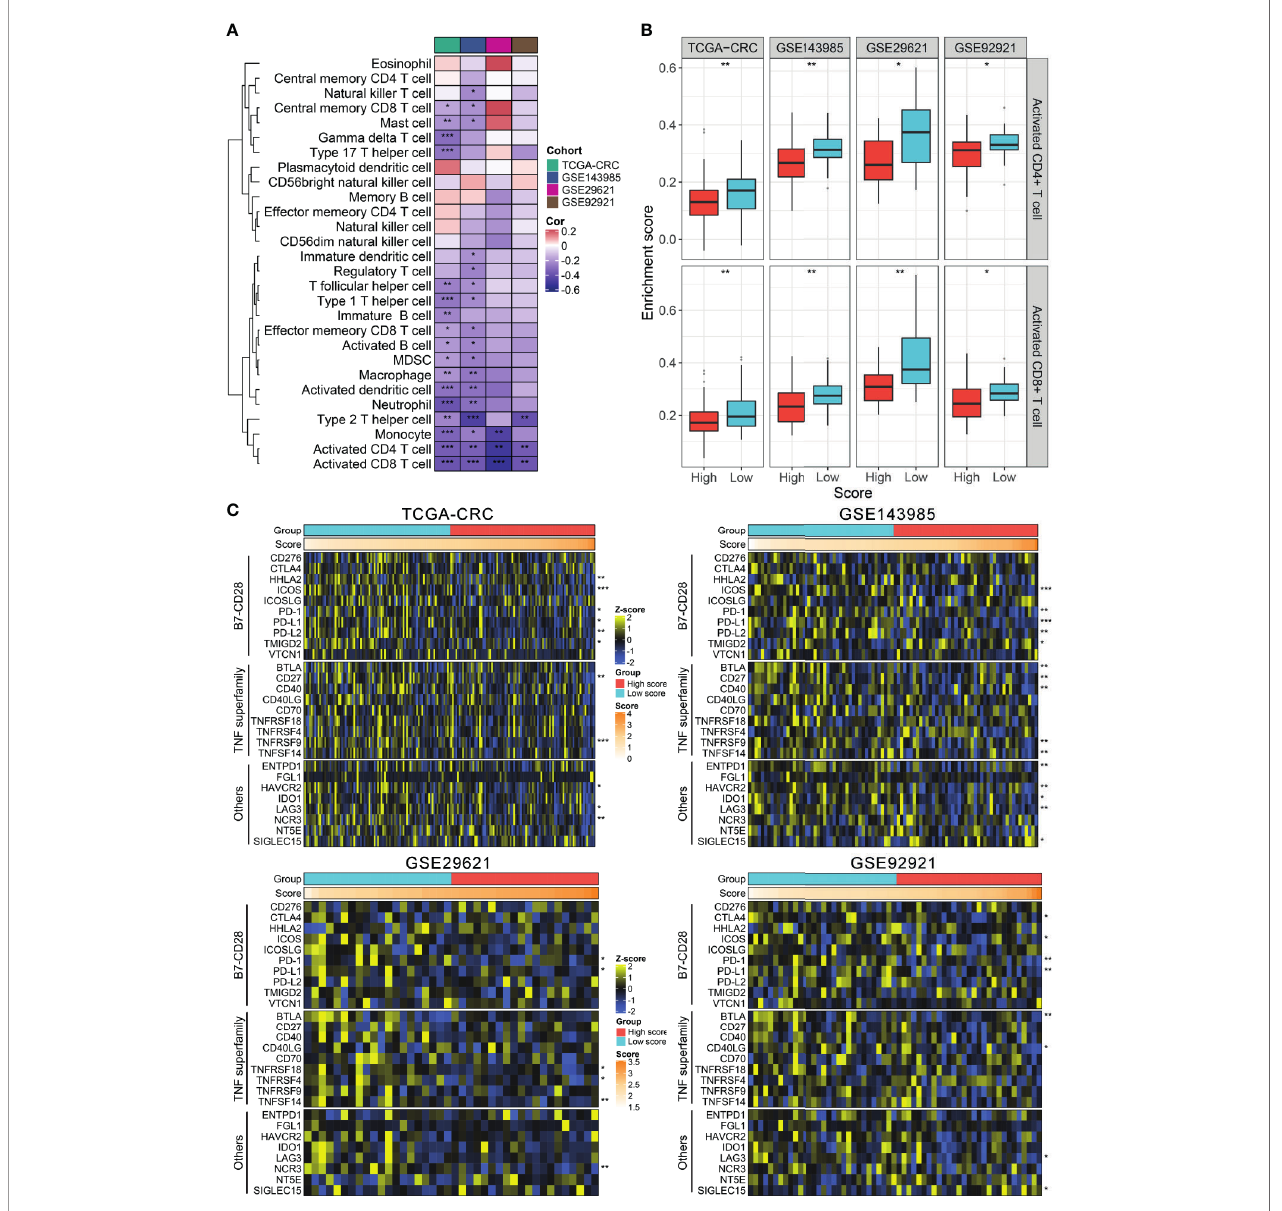
FIGURE 5 | TIME landscape and immune checkpoints pro fi les of RAIS in four cohorts. (A) The correlation analysis between RAIS and 28 immune cells in fi ltration abundance. (B) The distribution difference of activated CD4+/CD8+ T cells in fi ltration between the high-risk and low-risk groups. (C) Four heatmaps of 27 immune checkpoints pro fi les in high-risk and low-risk groups. *P < 0.05, **P < 0.01, ***P <